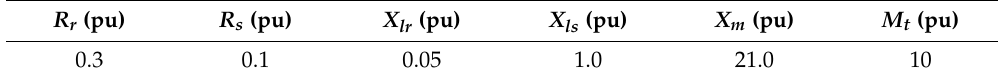
Table A2. Wind Turbine Parameters And Operating